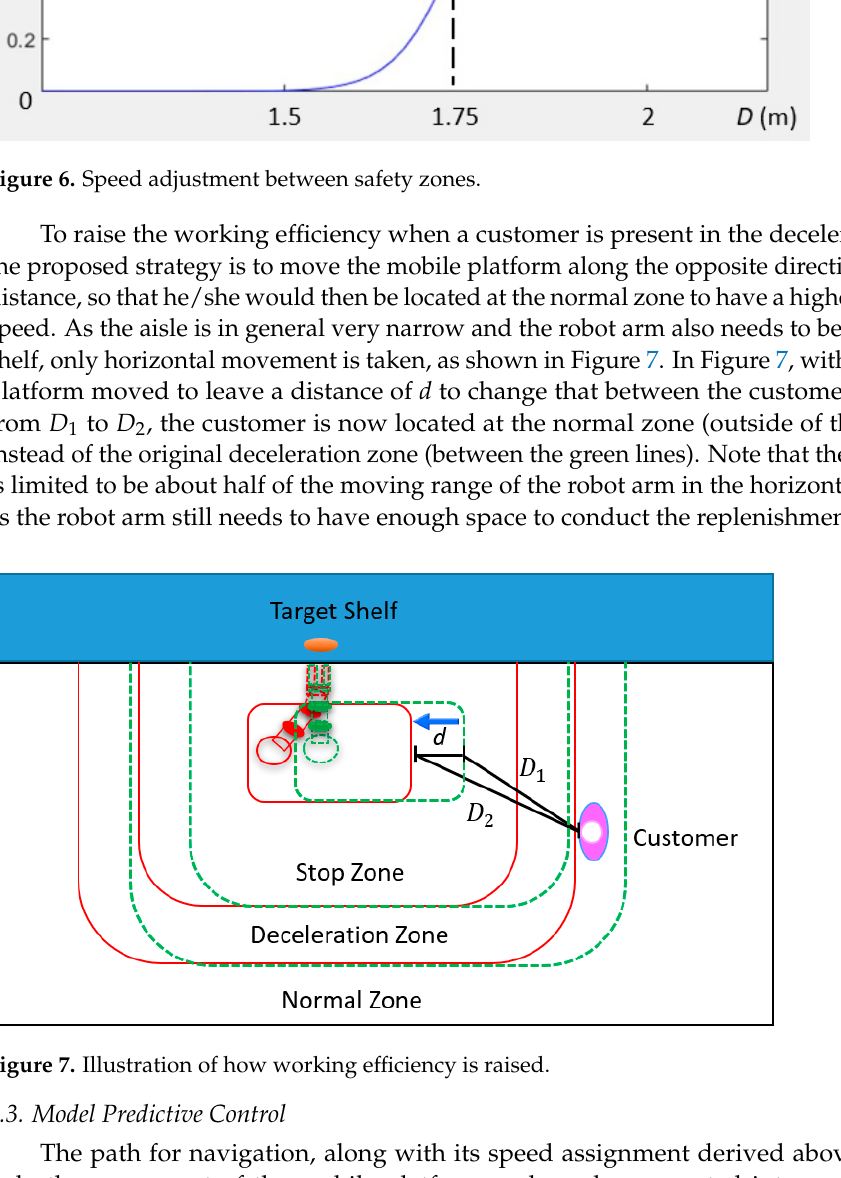
Figure 6. Speed adjustment between safety zones.